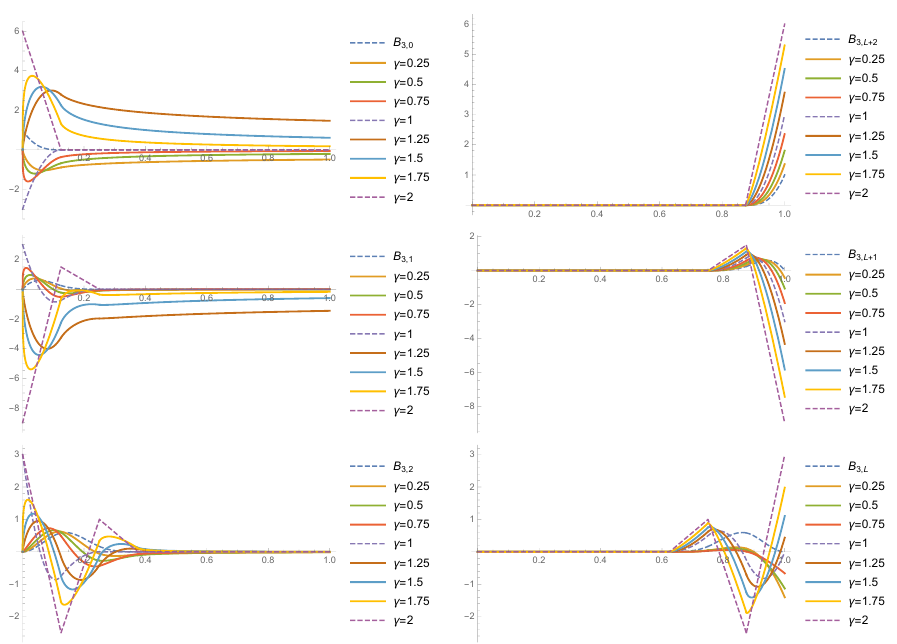
Figure 3. The fractional derivative of the left boundary functions ( left panels ) and of the right boundary functions ( right panels ) of the cubic B-spline basis B 3 for different values of the fractional order γ . The boundary functions and their first ( γ = 1) and second ( γ = 2) derivatives are plotted as dashed